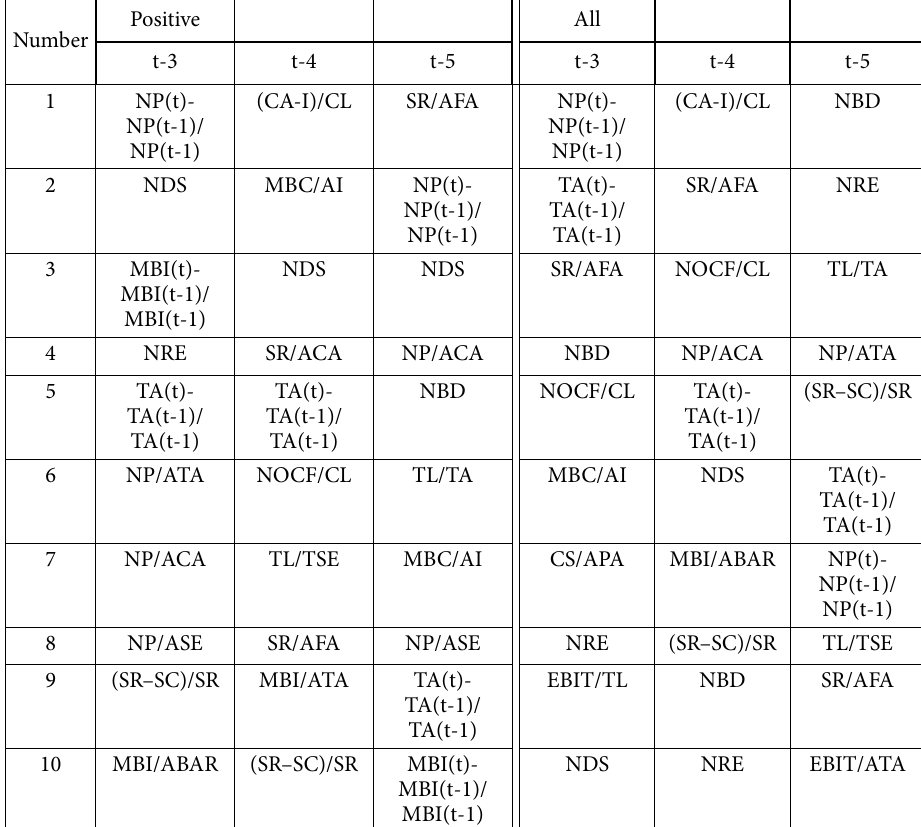
Table 10. Top 10 indicators of importance for positive and all